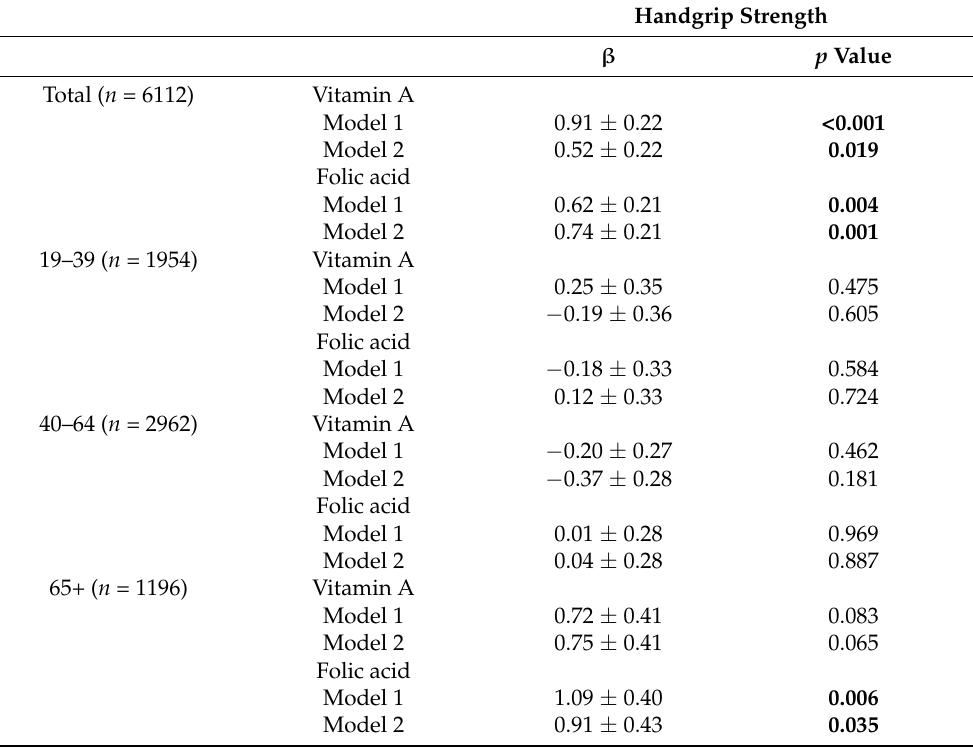
Table 2. Models of association between level of vitamin A and folic acid and handgrip strength. Handgrip Strength β p Value Total ( n = 6112) Vitamin A Model